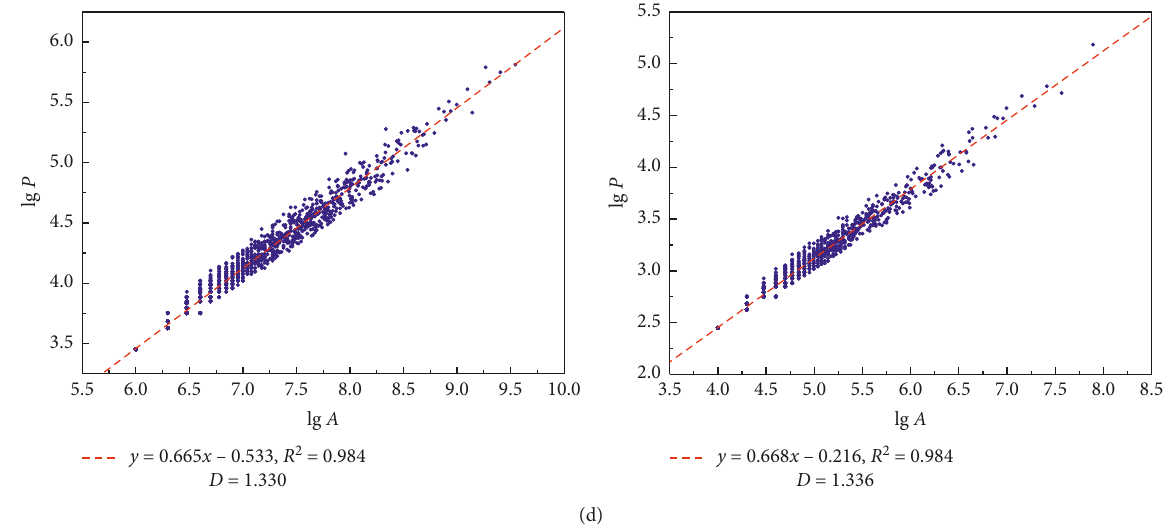
Figure 14: Fitted curve of fractal dimension of pore morphology. (a) Plain soil ( × 100); (b) 10% F+5% L stabilized soil ( × 100); (c) plain soil ( × 1000); (d) 10% F+5% L stabilized soil ( ×